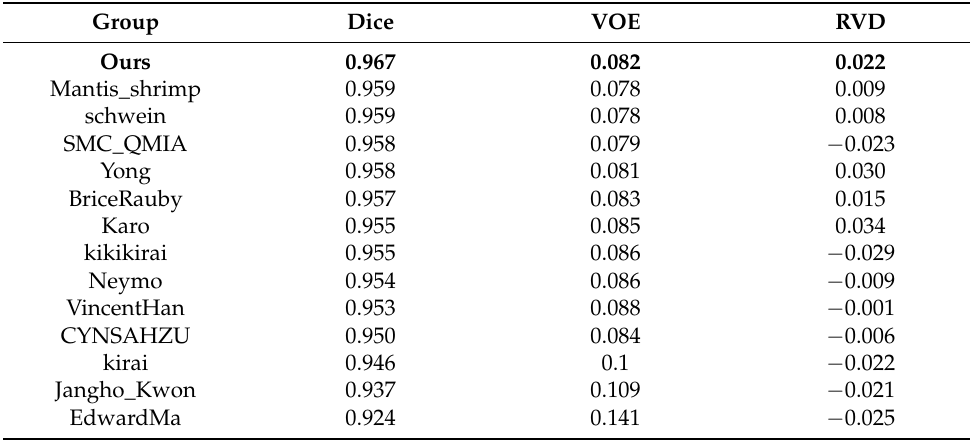
Table 7. Comparison of liver segmentation.